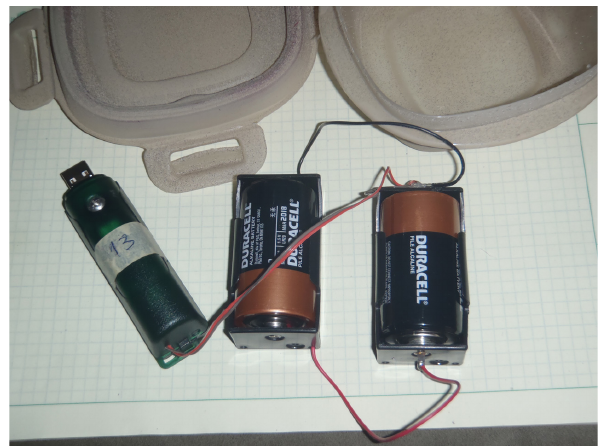
Fig. 3. Sand-colored waterproof food container used to house 2-D cells and the pressure logger for field measurements.